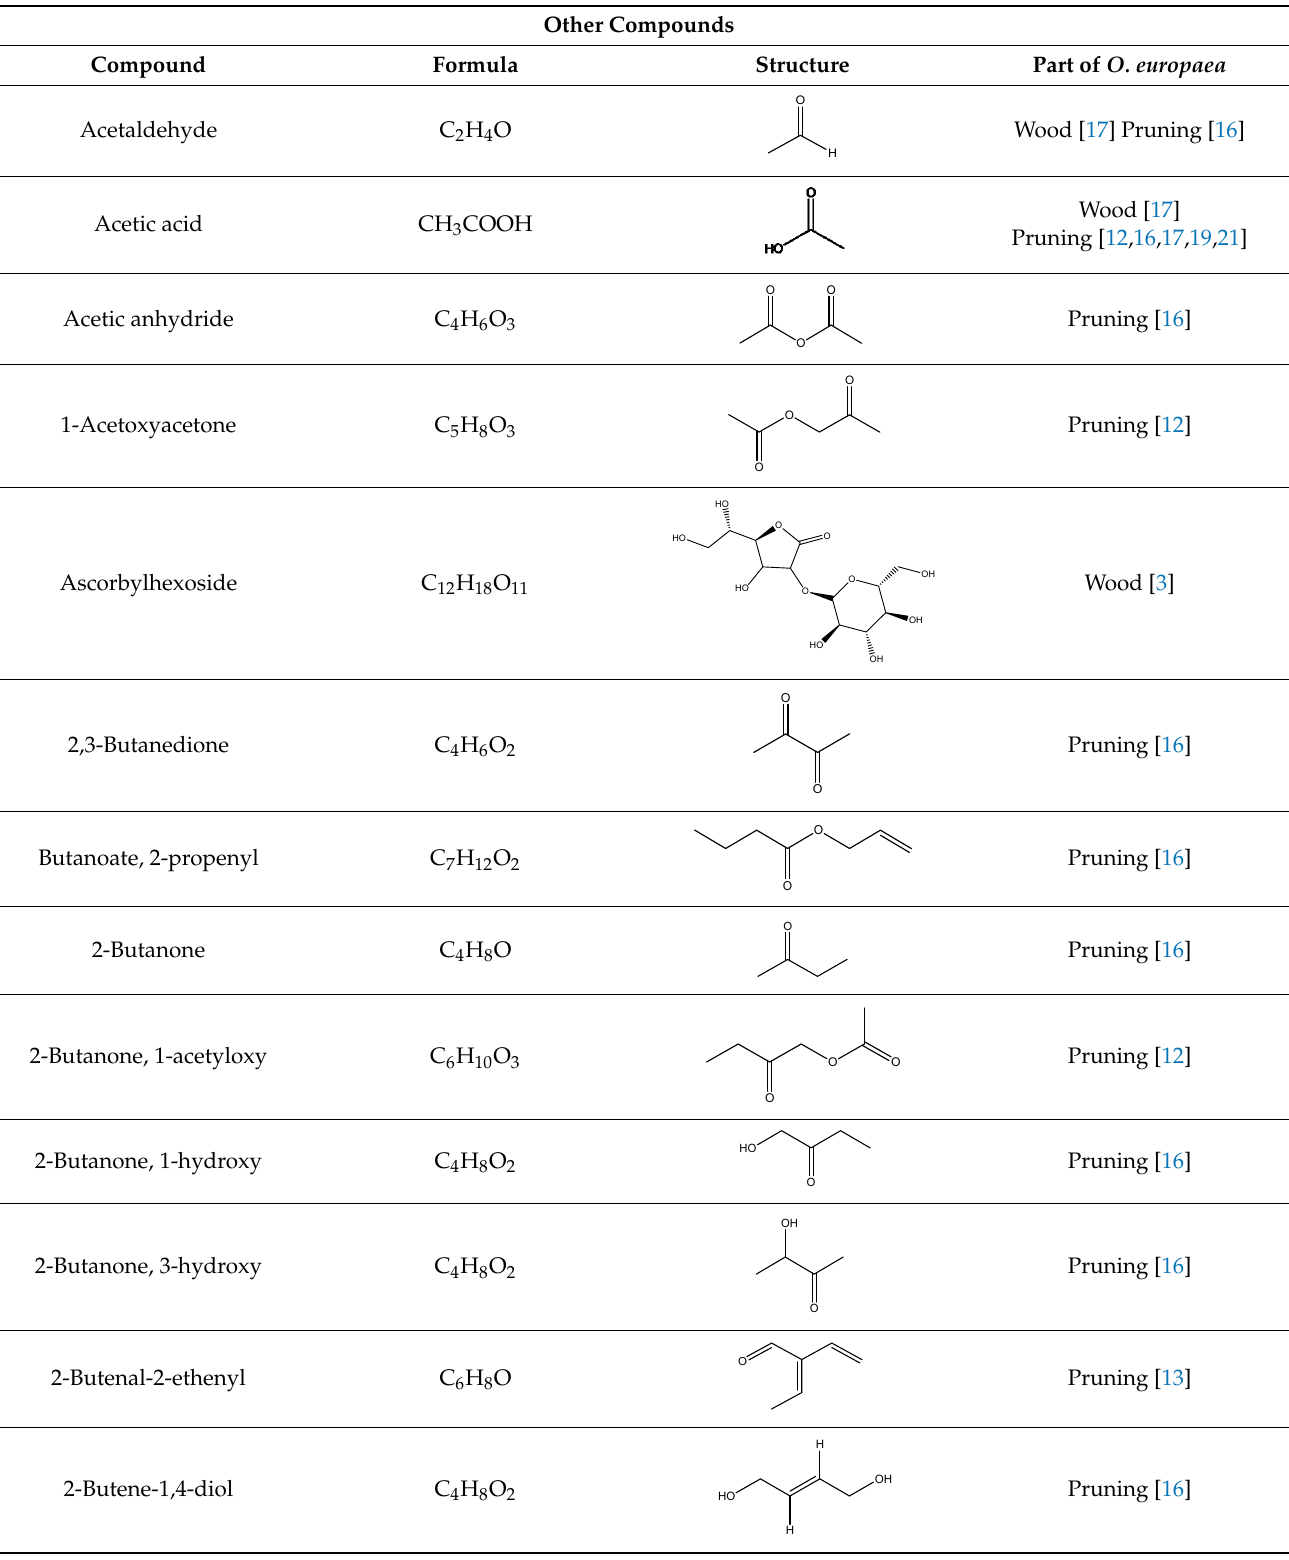
Table 1. Cont. Other